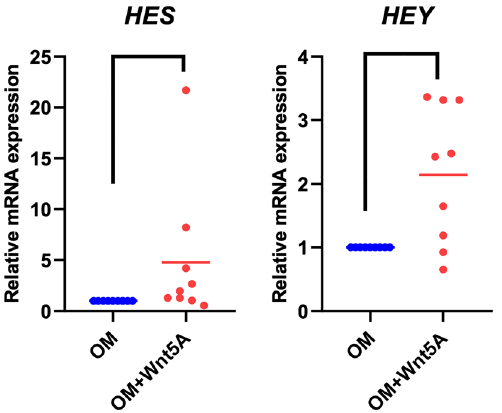
Figure 6. Reciprocal control between Notch and Wnt pathway. The cells were cultured in osteo/odontogenic medium supplemented with 200 ng/ml WNT5A for 7 days. The effects of WNT5A on Notch signaling